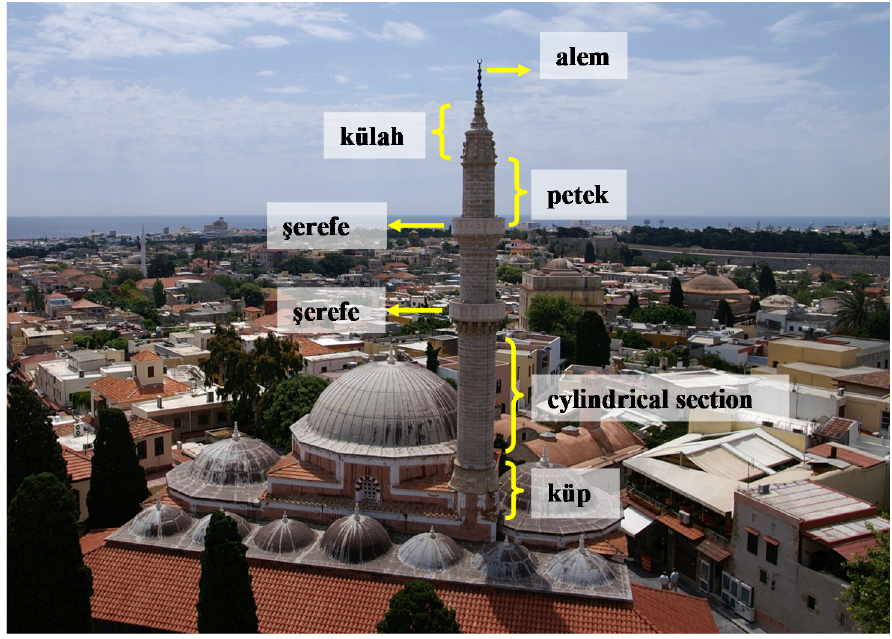
Figure 3. Description of the external typical parts of a minaret in height (modified after [46]).